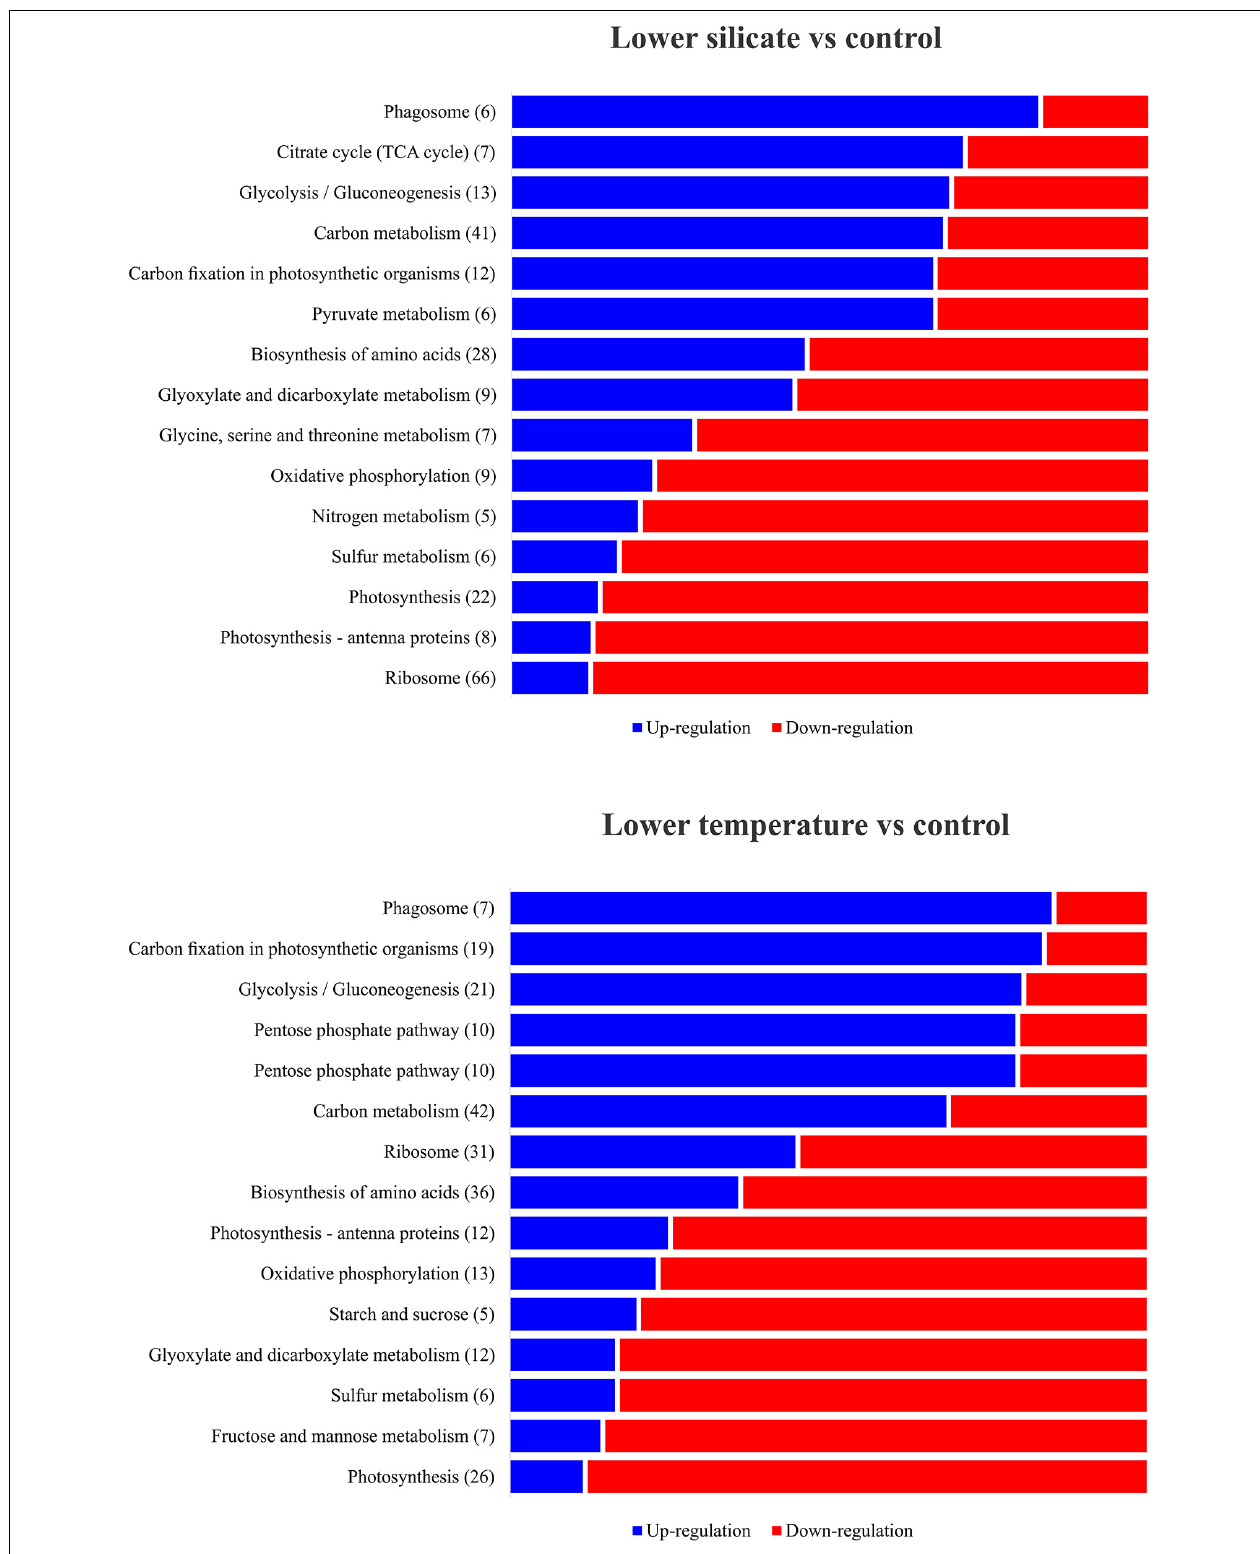
FIGURE 5 | Most represented KEGG pathway enrichment analysis of differentially expressed proteins in the diatom S. dohrnii ; those significantly enriched ( p < 0.05) under lower-silicate and lower-temperature cells were denoted as upregulated (blue) and downregulated (red) within each pathway.